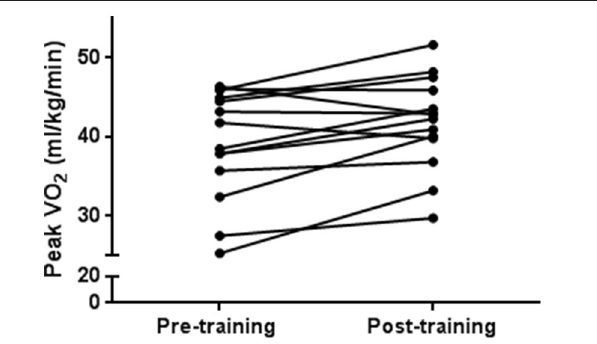
FIGURE 1 | Aerobic fitness improves following exercise training. Each black circle and line pair represents one participant from pre-training to post-training. There was a statistically significant training effect on peak ˙VO 2 ( p = 0.008).